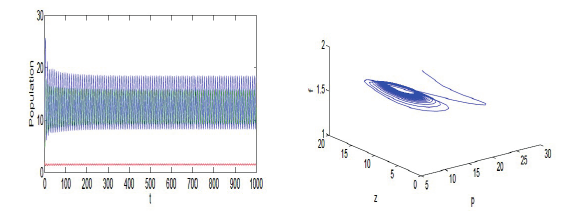
Fig. 5: Global continuation of periodic solutions around R * for τ = 25 > τ